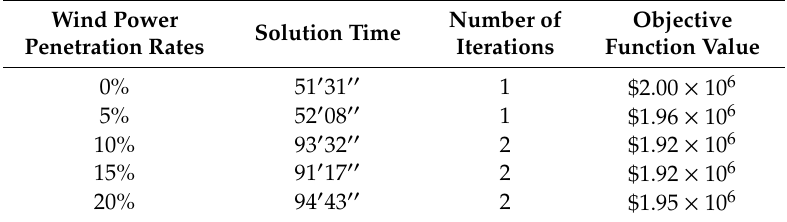
Table 3. Solution information under di ff erent wind power penetration rates.